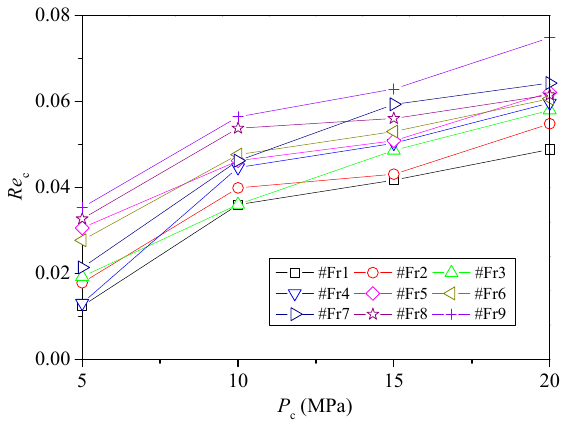
Figure 8. Relationships between factor E and the Reynolds number.